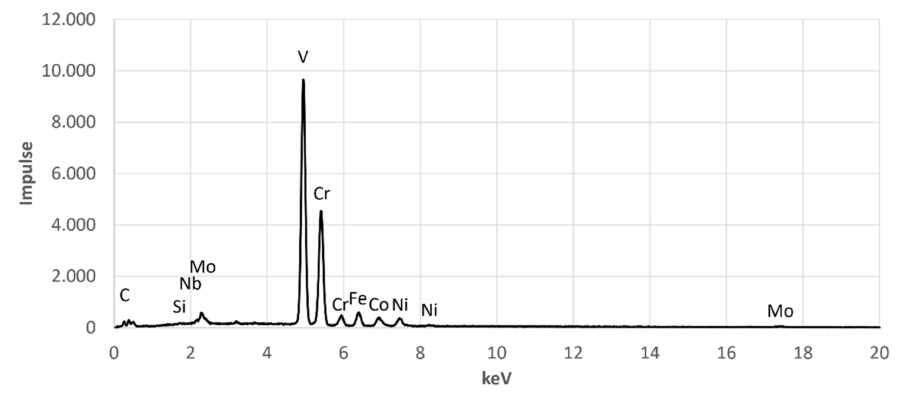
Figure A2. EDX-Spectrum for EDX Point 2.